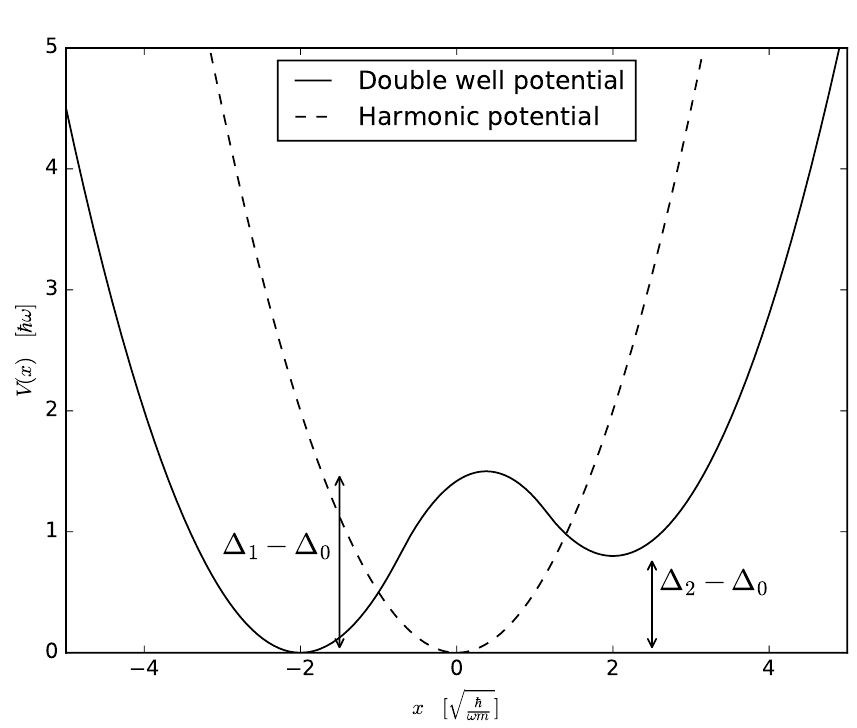
Figure 1: The two potentials used in this paper, the harmonic well with angu- lar frequency ω and the double well described in Appendix C with parameters (cid:113) ħ h = − x = 2 ω = ω ≡ ω , ∆ = 0, ∆ = 1.5 × ħ h ω and ∆ x ω m , 2 0 0 1 0 1